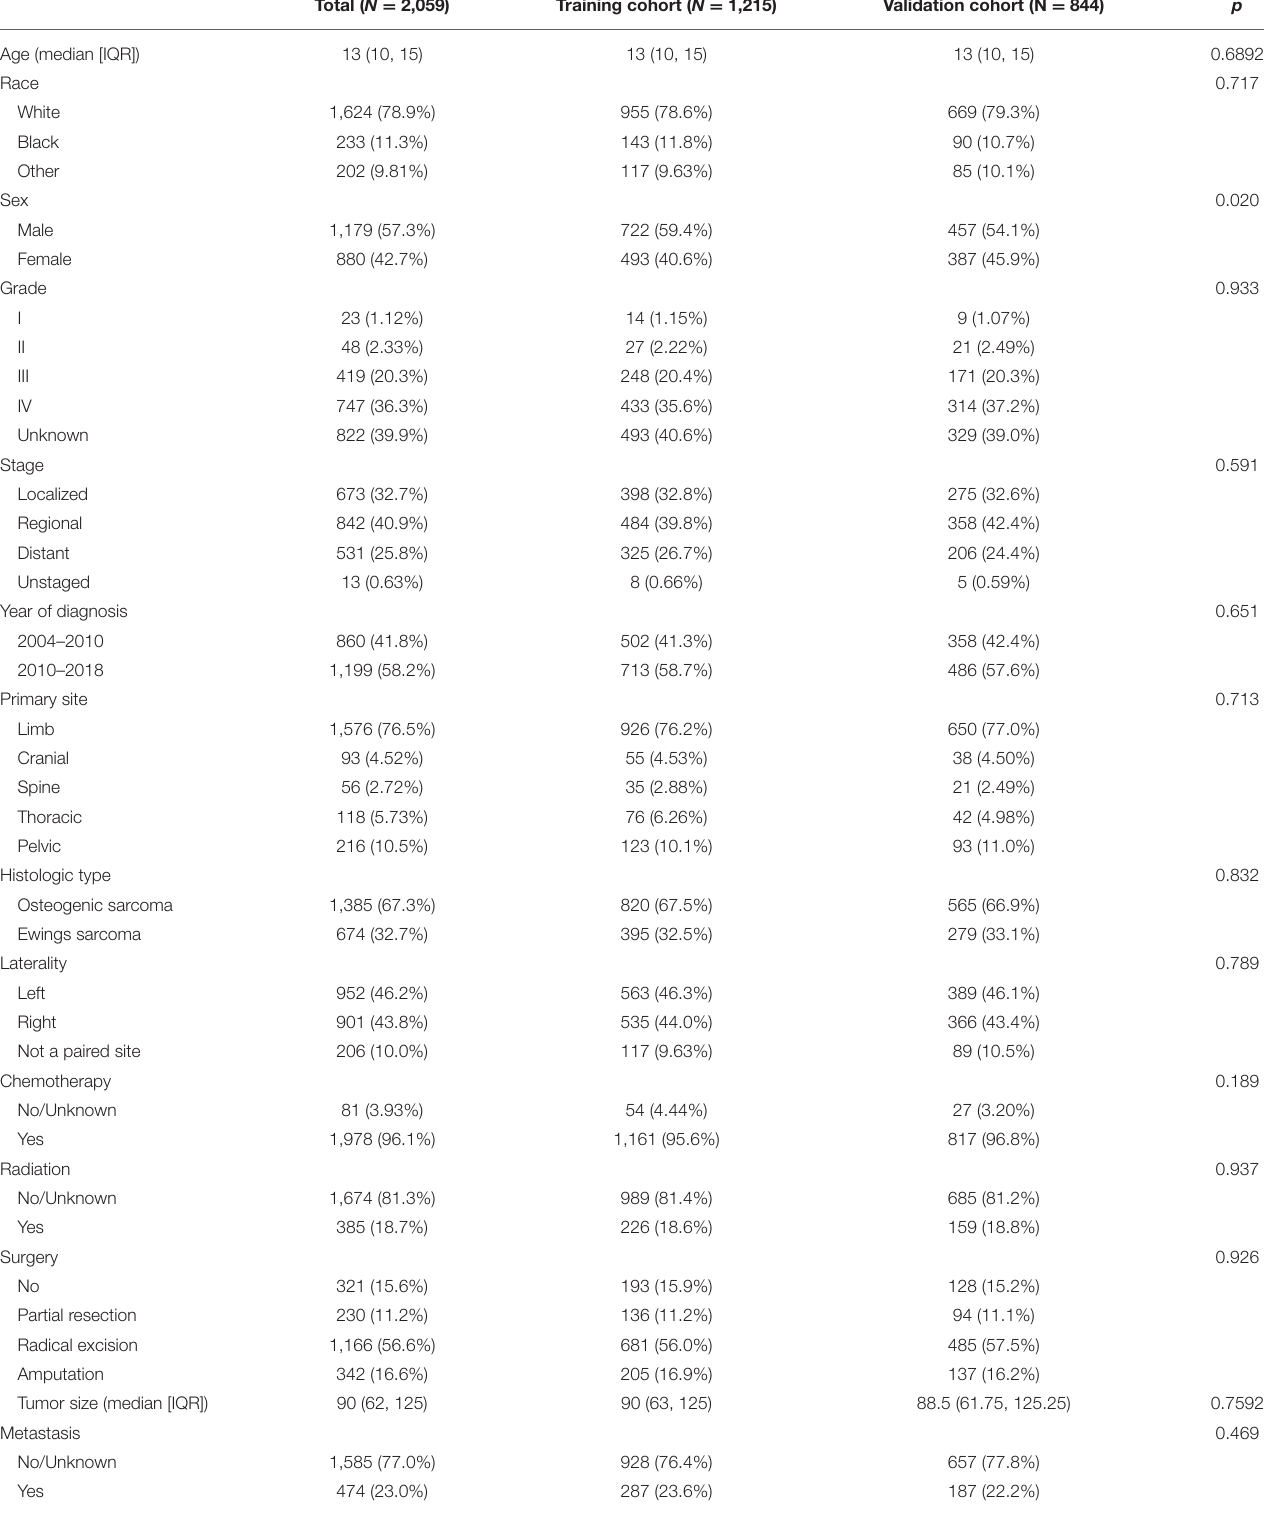
TABLE 1 | Clinicopathological characteristics of children with bone